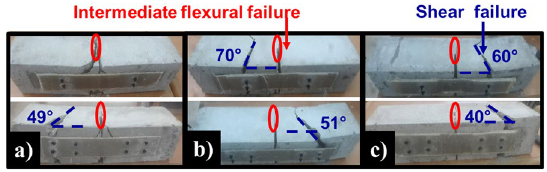
Fig. 8 Typical failure modes for beams strengthened with bolt (Diameter 6 mm)-glass fiber polymer composites (BGFPC) systems: a without using end-anchorage GFRP; b end-anchorage GFRP of 2.4 mm thickness; c end-anchorage GFRP of 4.8 mm thickness